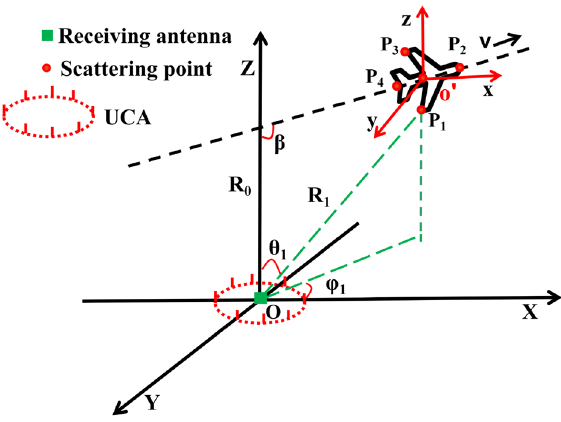
Figure 1. Geometry of the 3-D vortex ISAR